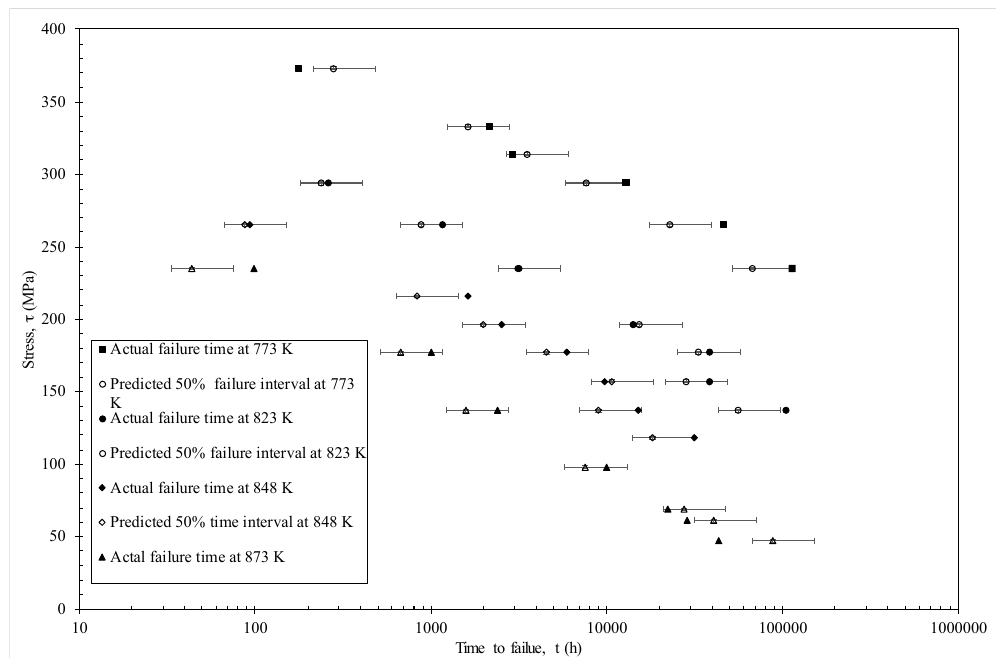
Figure 9. Actual log failure times plotted against predicted log failure times obtained from the model given by Equation (19f).